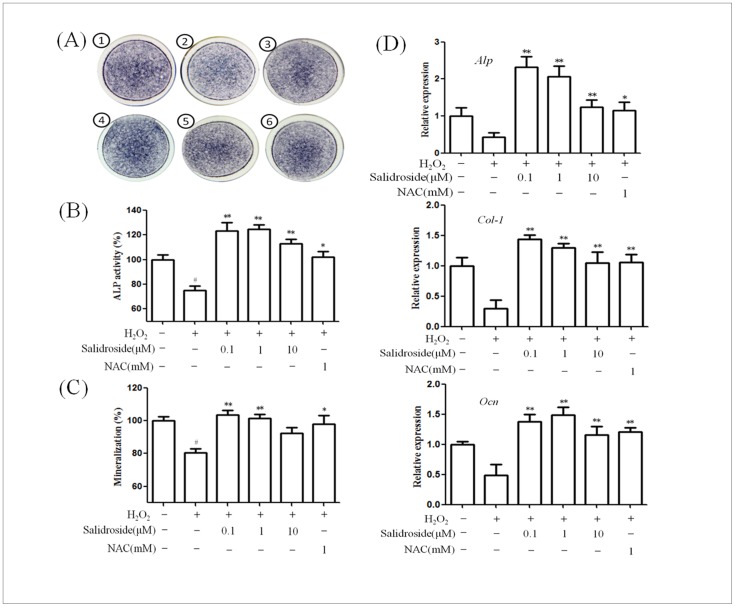
Protective effect of salidroside on H2O2 induced osteoblast dysfunction.After differentiation induction of 6 or 14 days, MC3T3-E1 cells were pretreated with salidroside for 24 h before treatment with 0.3 mM H2O2 for 24 h. NAC was used as positive control. A: Effect of salidroside on the ALP staining of MC3T3-E1 cells in the presence of H2O2. <$>\raster(70%)="rg1"<$> the control group; <$>\raster(70%)="rg2"<$> H2O2; <$>\raster(70%)="rg3"<$> H2O2+ salidroside (0.1µM); <$>\raster(70%)="rg4"<$> H2O2+ salidroside (1µM); <$>\raster(70%)="rg5"<$> H2O2+ salidroside (10µM); <$>\raster(70%)="rg6"<$> H2O2+NAC(1 mM). B: Effect of salidroside on the ALP activity of MC3T3-E1 cells in the presence of H2O2. The control value for ALP activity was 0.682 ± 0.021 unit /µg protein. C: Effect of salidroside on the mineralization of MC3T3-E1 cells in the presence of H2O2. The control value for mineralization was 1.392±0.31 OD. D: Effect of salidroside on the mRNA expression of Alp, Col-1 and Ocn in the presence of H2O2. #
P<0.05 versus untreated control cells;*P<0.05 and **P<0.01 compared with the group treated with H2O2 alone.